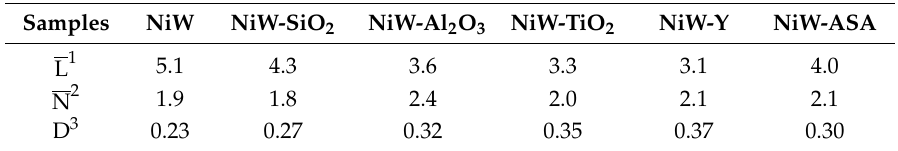
Table 1. Geometric characteristics of (Ni)WS 2 particles.